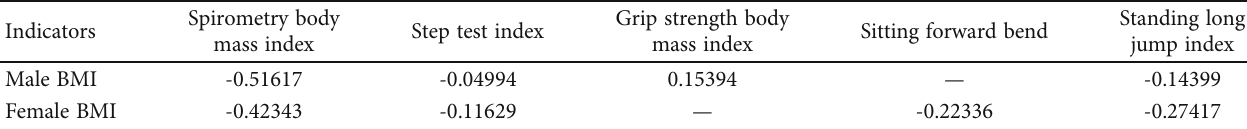
Standing long jump Table 3: Correlation coe ffi cient test between BMI and each index for male and female students. Indicators